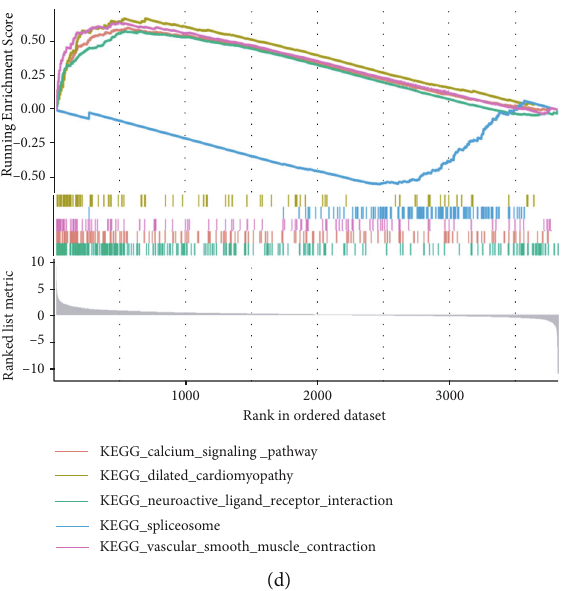
Figure 3: Pathway analysis between high and low expression of ARMCX1 in GC patients. (a) Heat maps of the DEGs between the high and low ARMCX1 expression groups. (b) Bubble diagram of Kyoto Encyclopedia of Genes and Genomes mechanism analysis. (c) GO analysis of the DEGs between the high and low ARMCX1 expression groups. (d) Signi fi cant pathways identi fi ed by GSEA